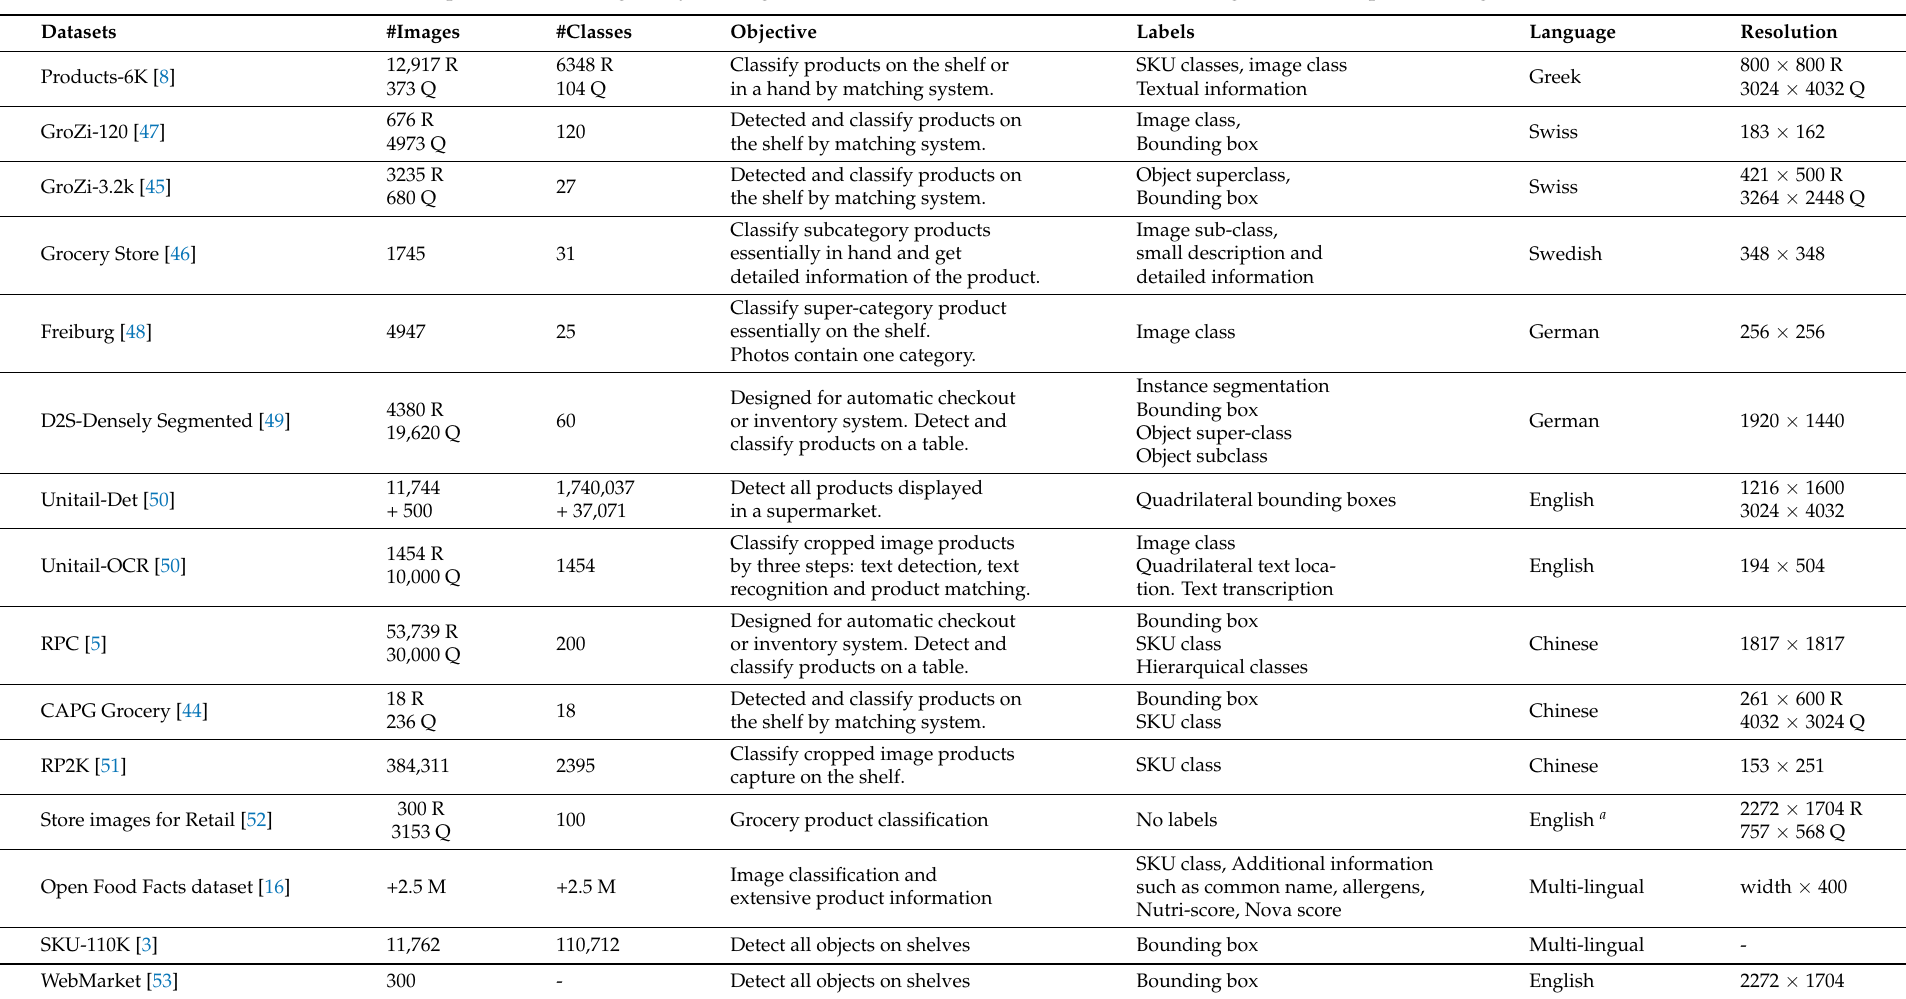
Table 2. Comparison between grocery and logo datasets. The letter “R” means reference images, and “Q” queries images. The indicated resolution is